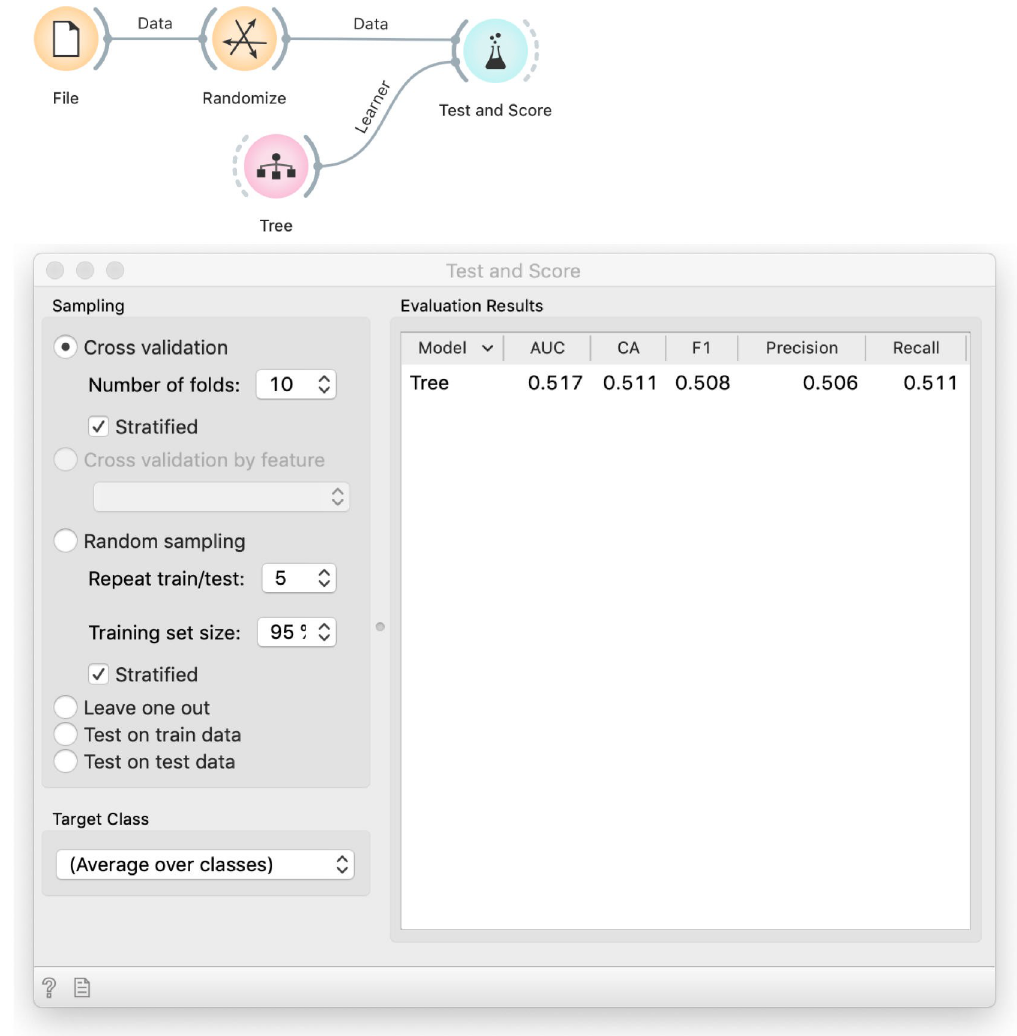
Fig 6. Testing with cross-validation. The Tree widget receives no data and does not output a tree but only an algorithm (a¨ recipe") for building one. The Randomize widget, which shuffles the data, is here only to demonstrate that cross validation discovers overfitting by showing a small accuracy. In practice, we would use the actual, non-randomized